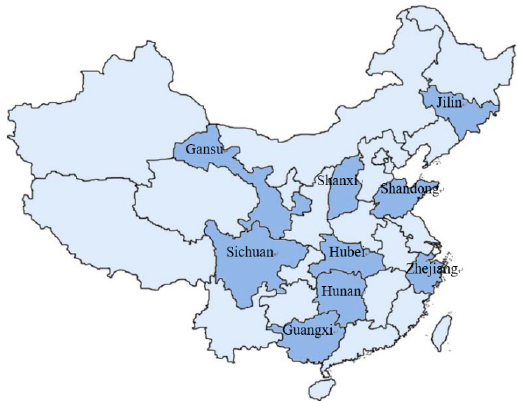
Figure 1. Location of nine investigated provinces of China.